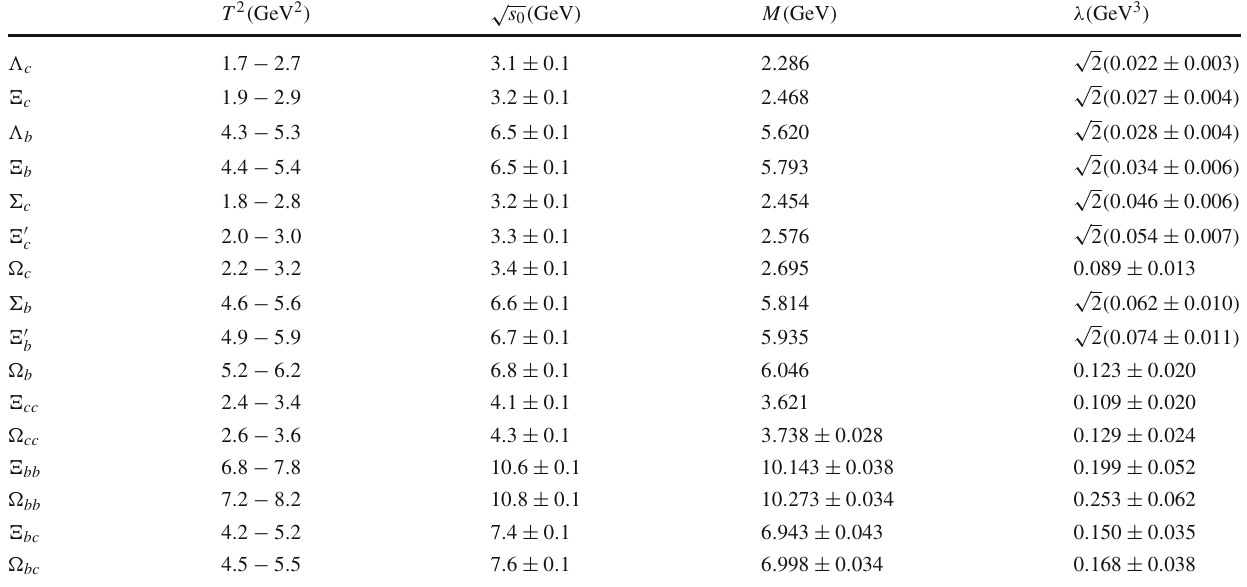
Table 2 “Decay constants” (pole residues) for the doubly-heavy and convention differences in the definitions of the interpolating current for singly-heavy hadrons as well as their masses. Results for charmed and baryon. The mass of (cid:2) ++ cc comes from the experiment [1] and the other bottom baryons are taken from Refs. [54,55], while for the doubly- masses of doubly-heavy baryons are predictions of Lattice QCD [56]. heavy baryons we have updated the pole residues in Ref. [18] using The masses for baryons with a singly-heavy quark are taken from the √ the same inputs as those in this work. The factor 2 arises from the